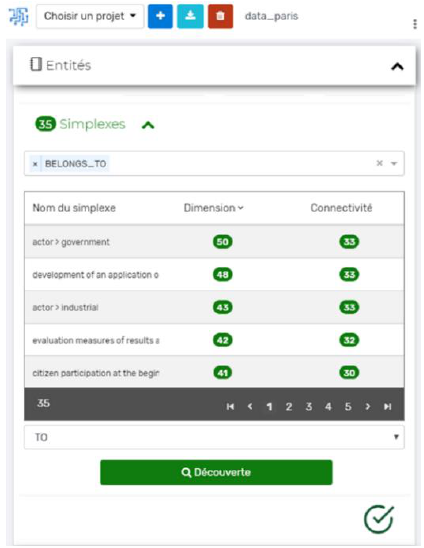
Figure 5. Hype screenshot: simplices, dimensions, and